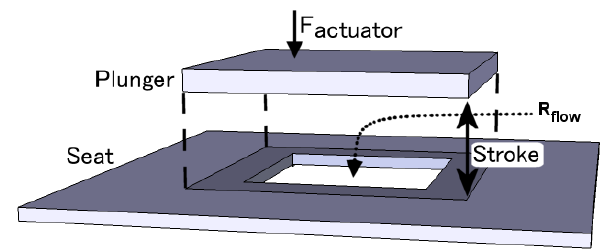
Figure 2. Typical structure and operating principle of a microvalve. The moving plunger covers an orifice in the valve seat, thus changing the flow